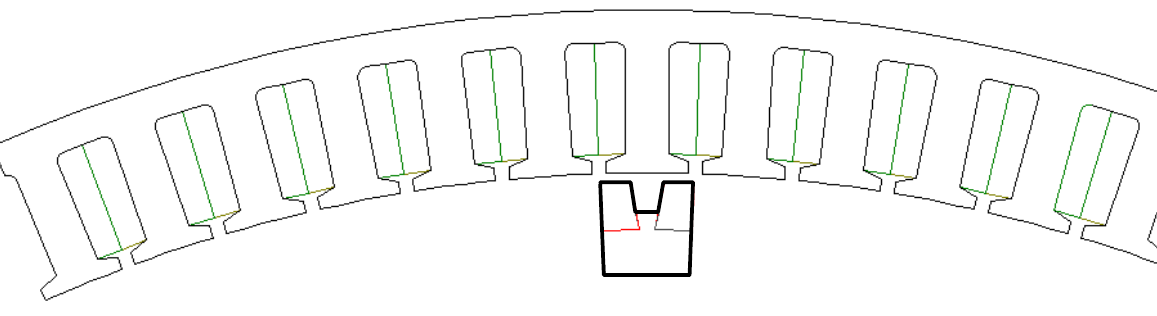
Figure 7. A group of HMPP geometry of the 100-pole, 96-slot machine.